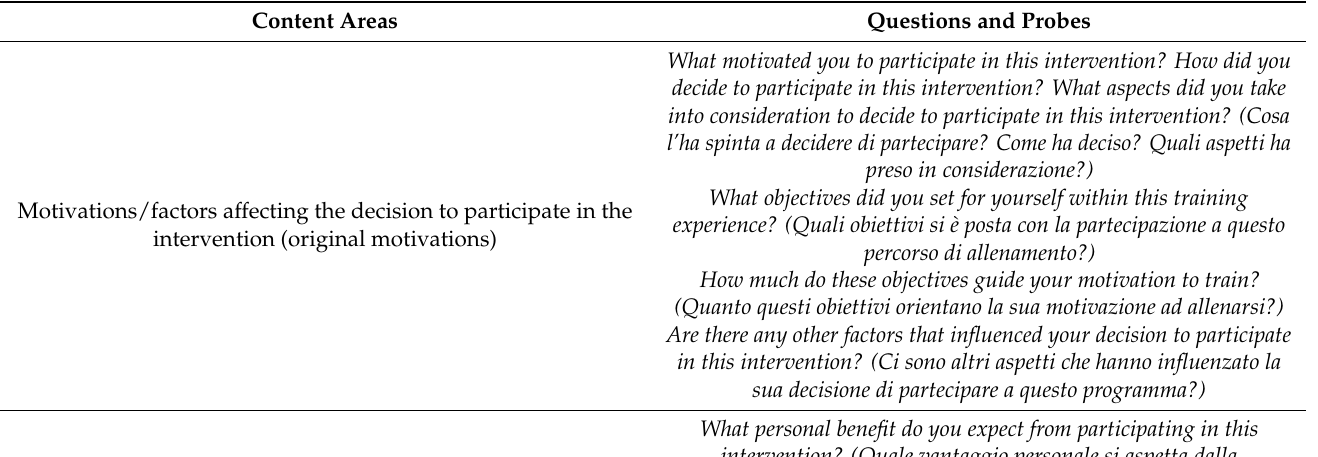
Table 1. Interview